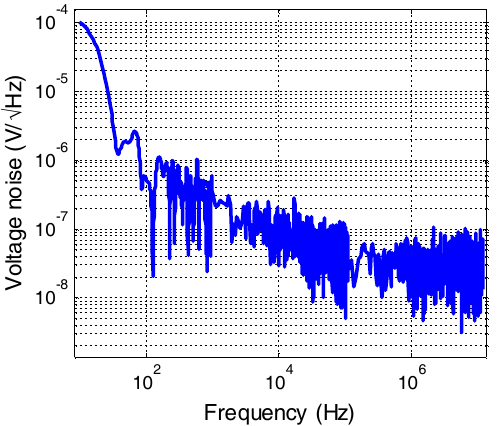
Figure 12. Output voltage noise spectra density measured results.